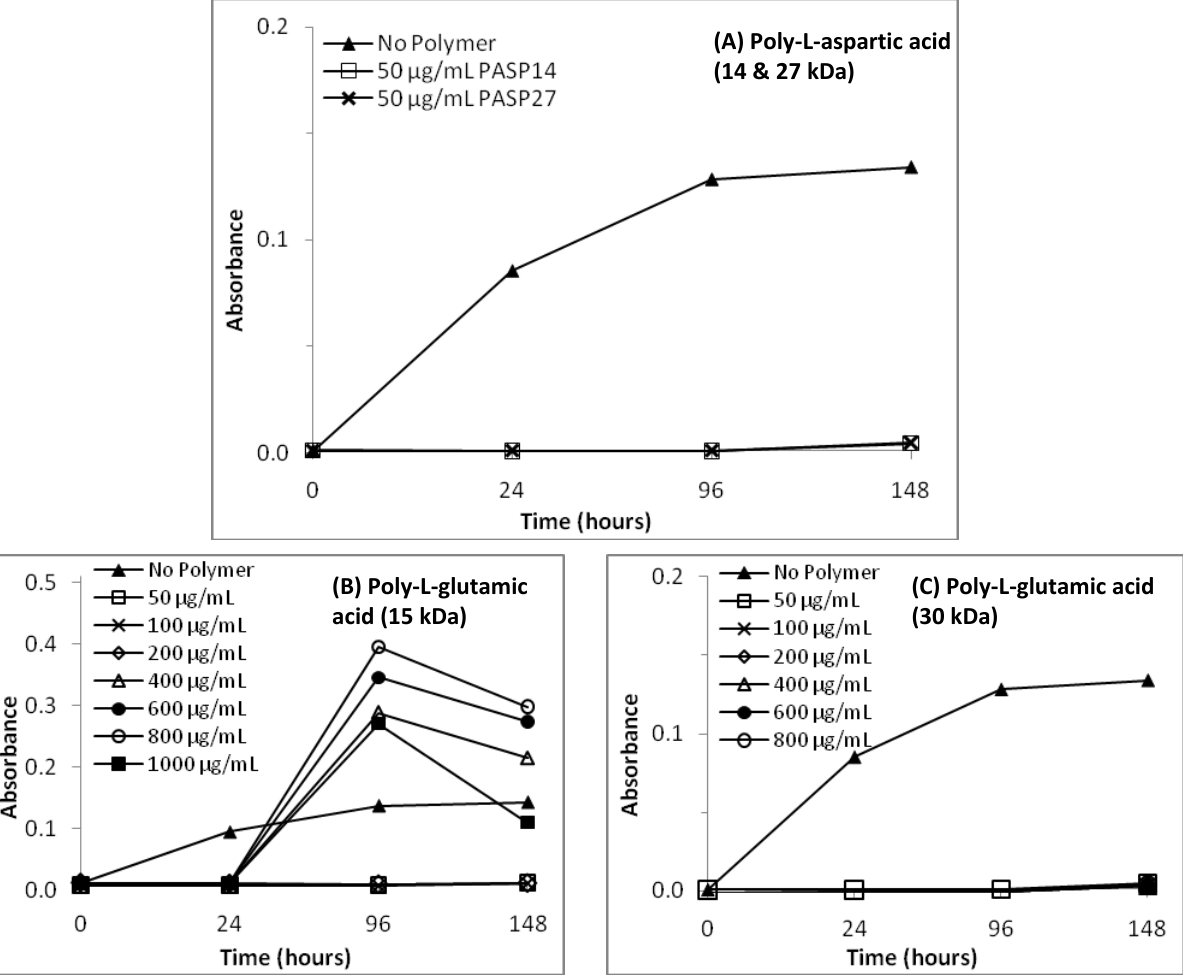
Figure 1. Effects of polyaspartic and polyglutamic acid concentrations in a supersaturated calcium-phosphate (CaP) solution. ( A ) Optical density profiles of the CaP solutions containing 50 µg/mL of 14 kDa or 27 kDa poly-L-aspartic acid (PASP14 or PASP27, respectively). ( B ) Optical density profiles of the CaP solutions containing 0–1,000 µg/mL 15 kDa poly-L-glutamic acid (PGLU15). The lines for concentrations 50–200 µg/mL are overlapping near the zero value. ( C ) Optical density profiles of the CaP solutions containing 0–800 µg/mL 30 kDa poly-L-glutamic acid (PGLU30). The lines for all concentrations are overlapping near